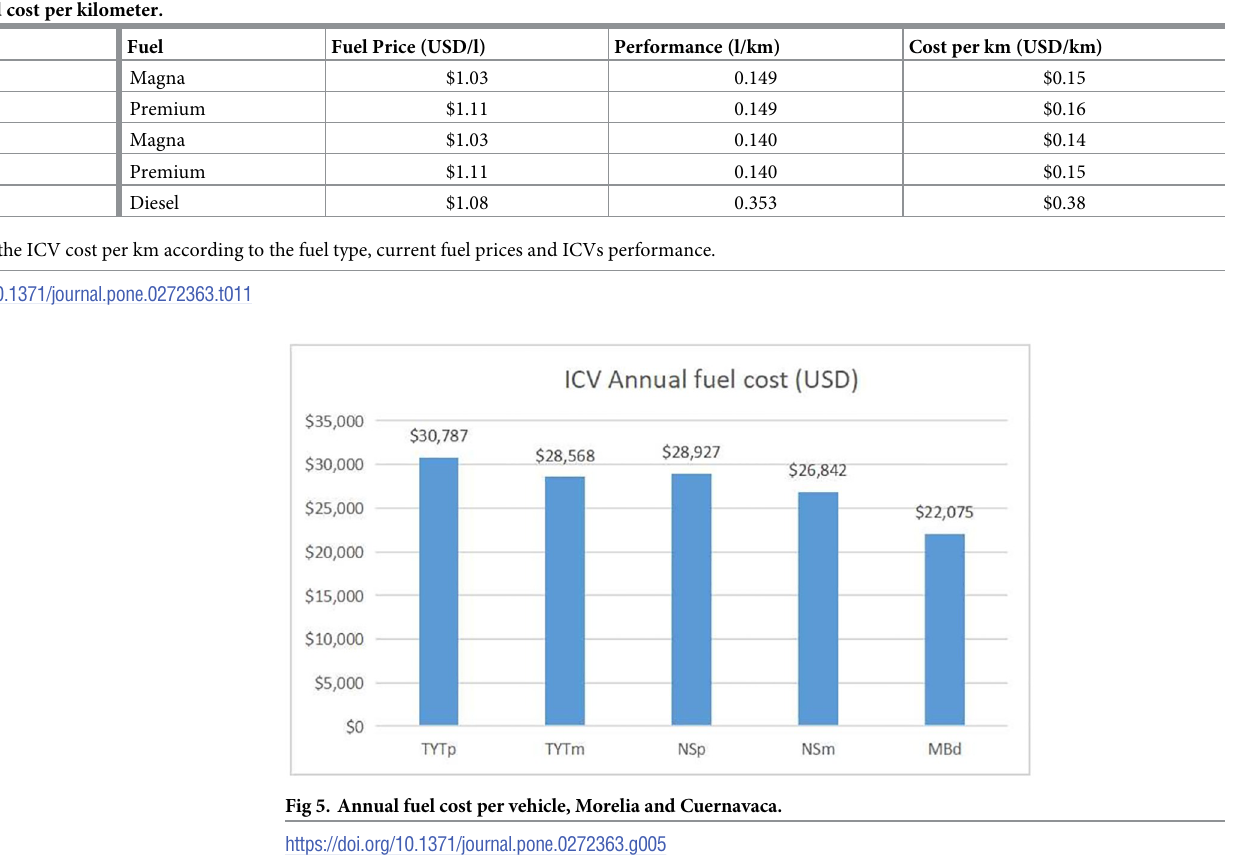
Table 11. ICVs cost per kilometer. Fuel prices and cost per kilometer.